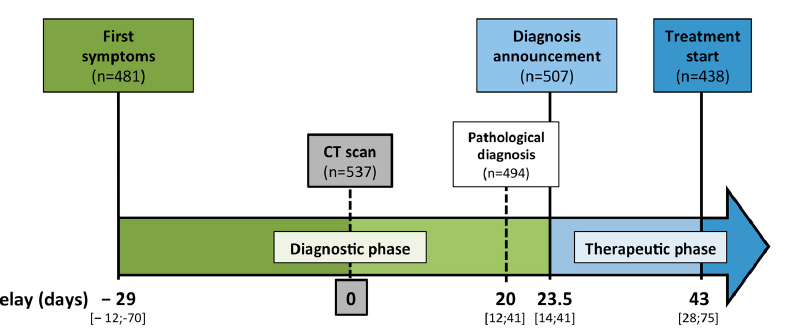
Figure 2. Timeline of the patient care pathway with median delays for each diagnostic and therapeutic step. As only 481 patients presented symptoms before the diagnosis, delay between symptoms and CT scan did not integrate patients with incidental disease. From the CT scan, the whole population was considered to determine the timeline with median delays. Treatment start excluded patients with exclusive best supportive care, as this care usually started without delay if needed. Delays are presented as median with IQR.